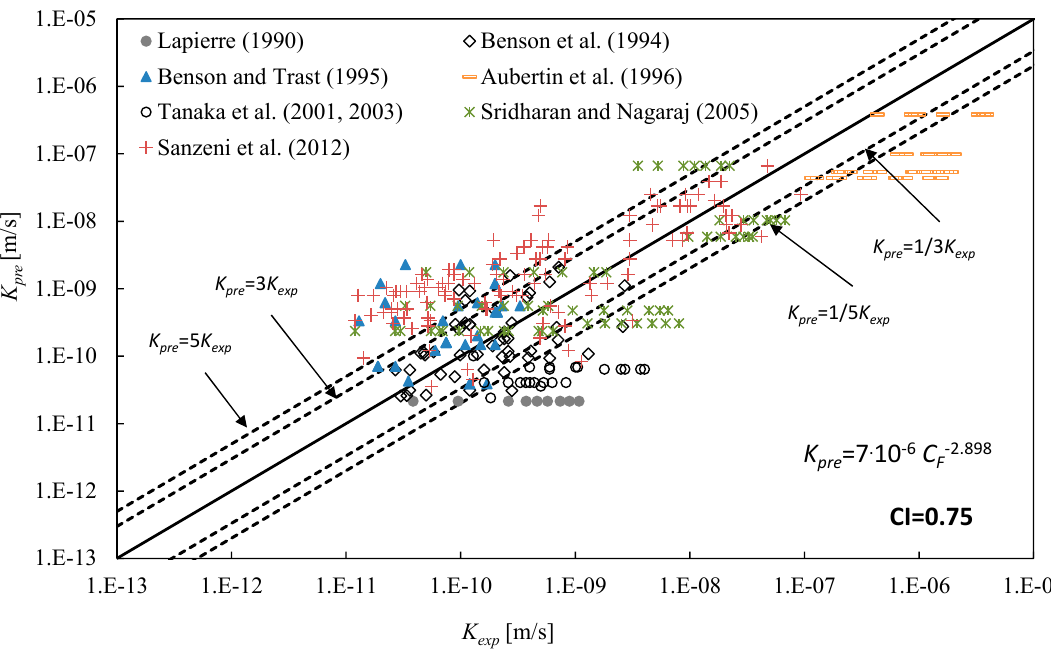
Figure 1. Experimental ( K exp ) and predicted value ( K pre ) of the saturated hydraulic conductivity as determined by Equation (18).